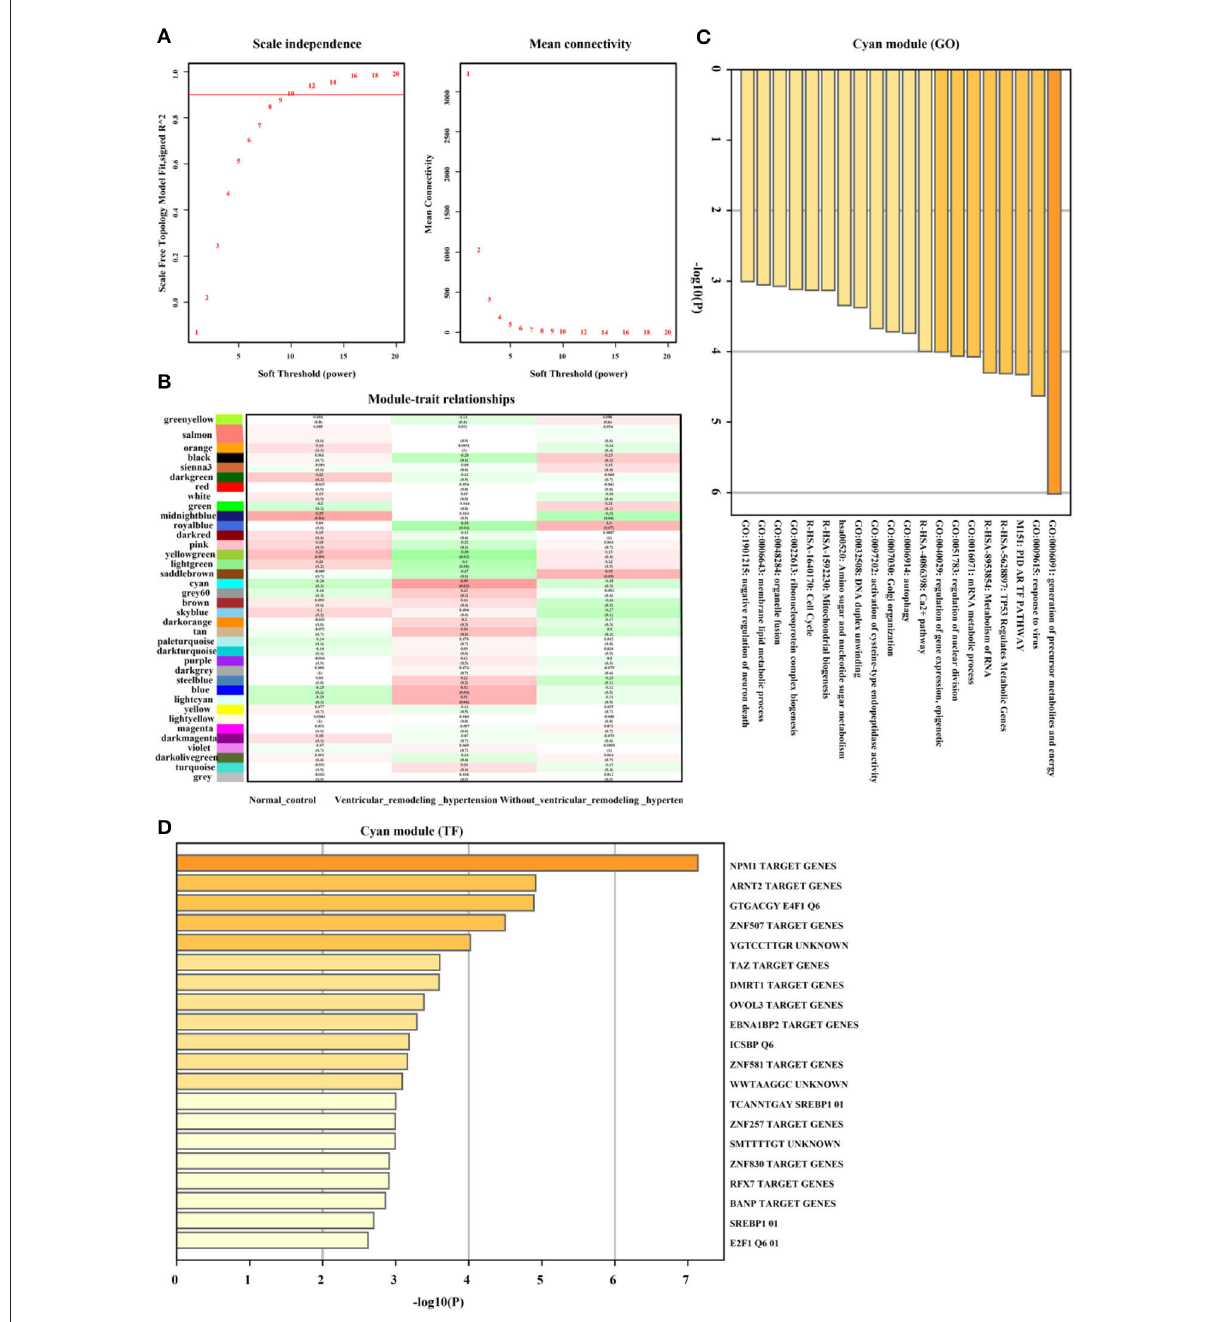
FIGURE6 Hypertension with left ventricular remodeling related gene module selection and functional enrichment analysis (GSE74144). (A) Robust threshold value to the selection. (B) A heatmap displaying the association with hypertension with left ventricular remodeling trait and neighboring genes modules. (C) The GO and KEGG enrichment analysis for optimal hypertension with left ventricular remodeling-related gene module. (D) Transcript factors enrichment analysis for optimal hypertension with left ventricular remodeling-related gene module.